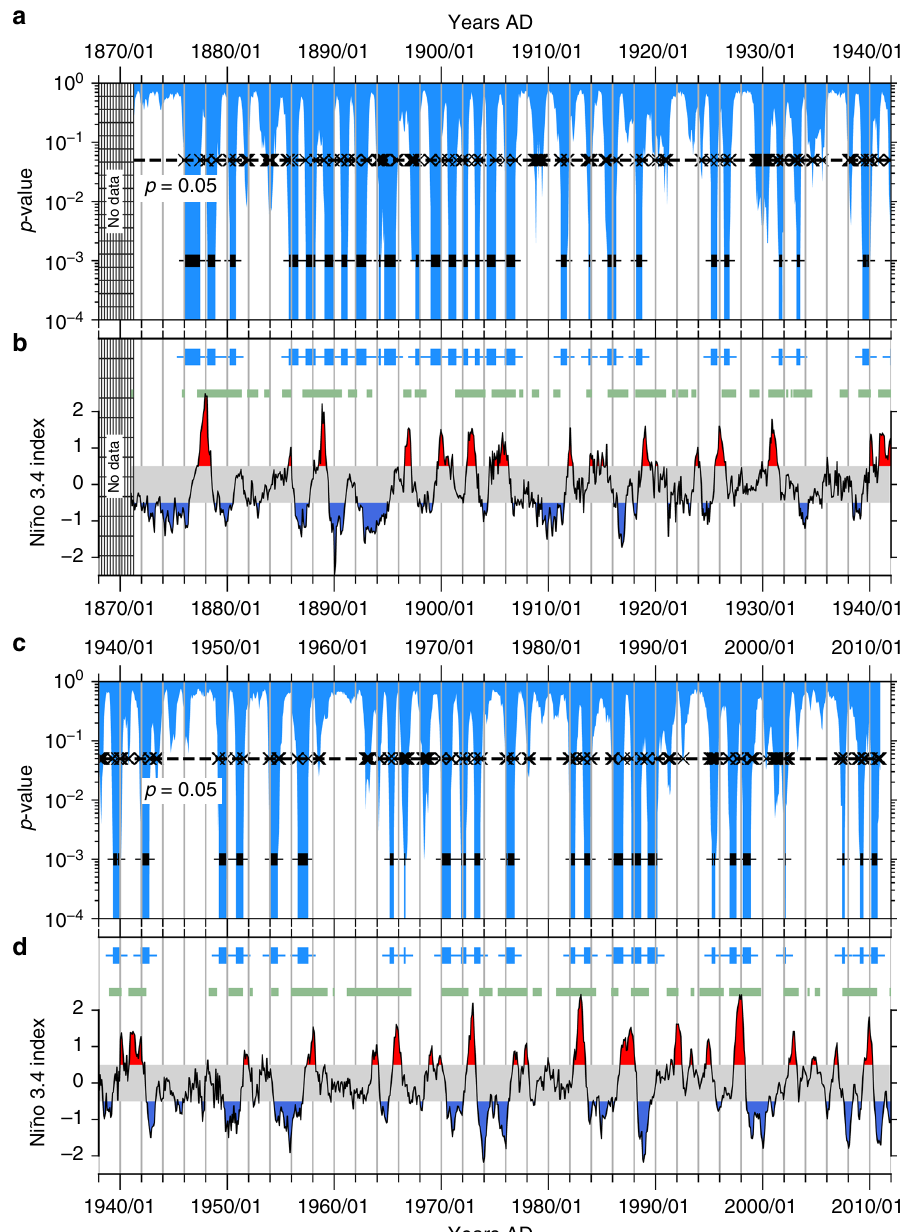
Fig. 4 Abrupt transitions in the equatorial central Paci fi c. In ( a , c ), the plus and cross signs, and the horizontal dashed lines denote the same as in Fig. 3. We detect most of the transitions between El Niño (La Niña) phases, shown here as red (blue) shaded regions in ( a , c ) during the past 150 years: a , b From 1870 up to 1940. c , d From around 1940 to 2012. From around 1906, the transitions show an intermittent burst-like behavior, indicating a complex interdecadal variability of the transitions themselves. A statistical coincidence analysis reveals that the timings of the detected transitions are signi fi cantly coincident to the timings of phase-locked periods (shown here as green markers in ( b , d )) between the PDO and the ENSO. This reveals a further potential aspect of the modulation of the ENSO by the